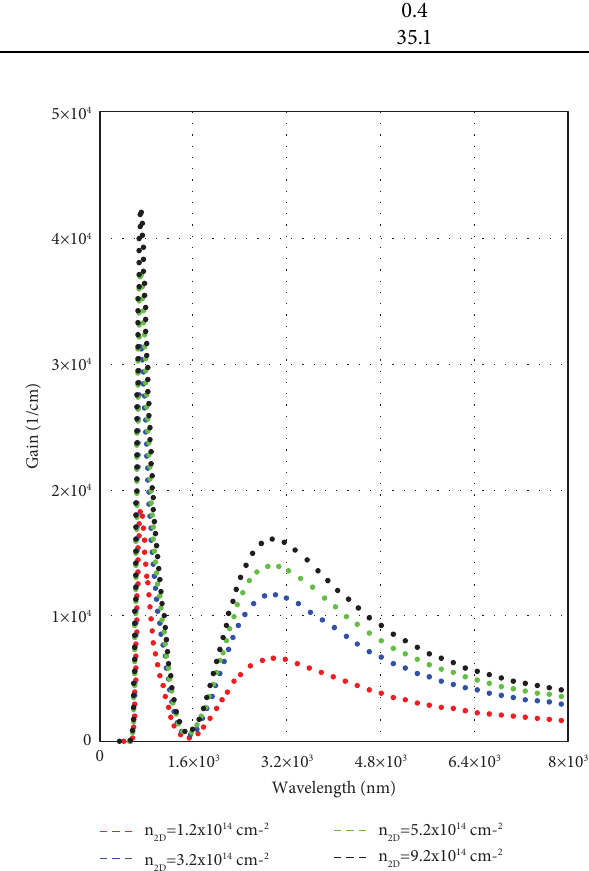
Figure 1: TlBr/BrCl QD gain at diferent carrier